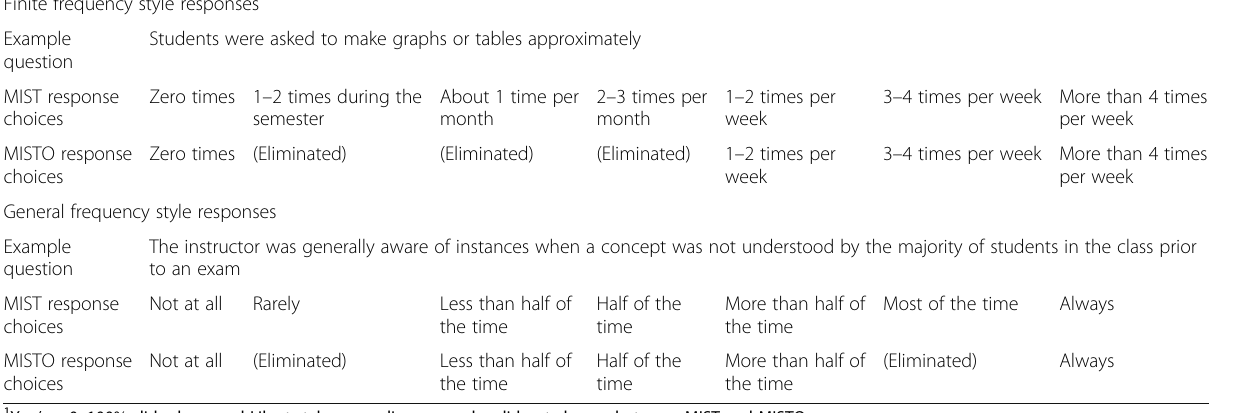
Table 3 Response scale conversion from MIST to MISTO